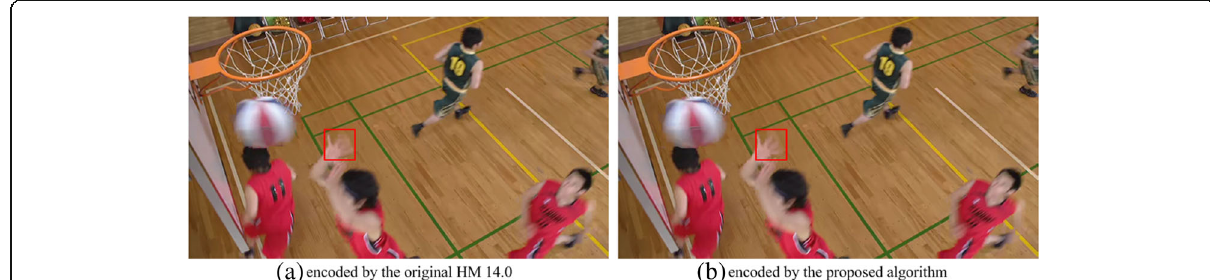
Fig. 9 Comparison of the subjective quality of the 32nd frame in test sequence “ BasketballDrill ” . a Encoded by the original HM 14.0. b Encoded by the proposed